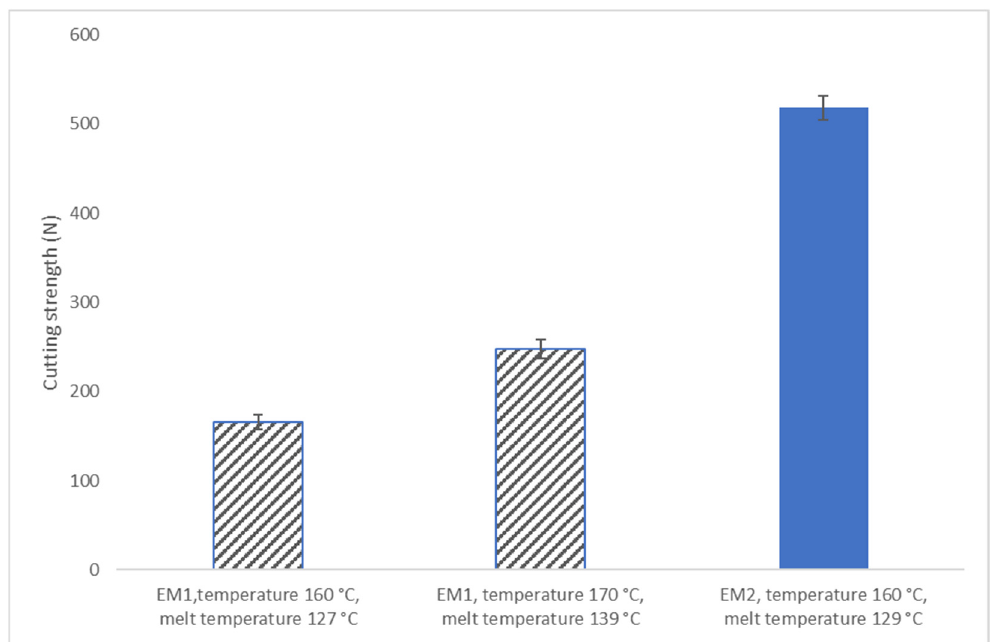
Figure 5. The cutting strength of the extrusion mixture 1 (EM1) (melt temperatures: 127 and 139 °C) and extrusion mixture 2 (EM2) (melt temperature: 129 °C) samples. The samples were placed longitudinally and blades of the Allo-Kramer shear cell cut them transversally.